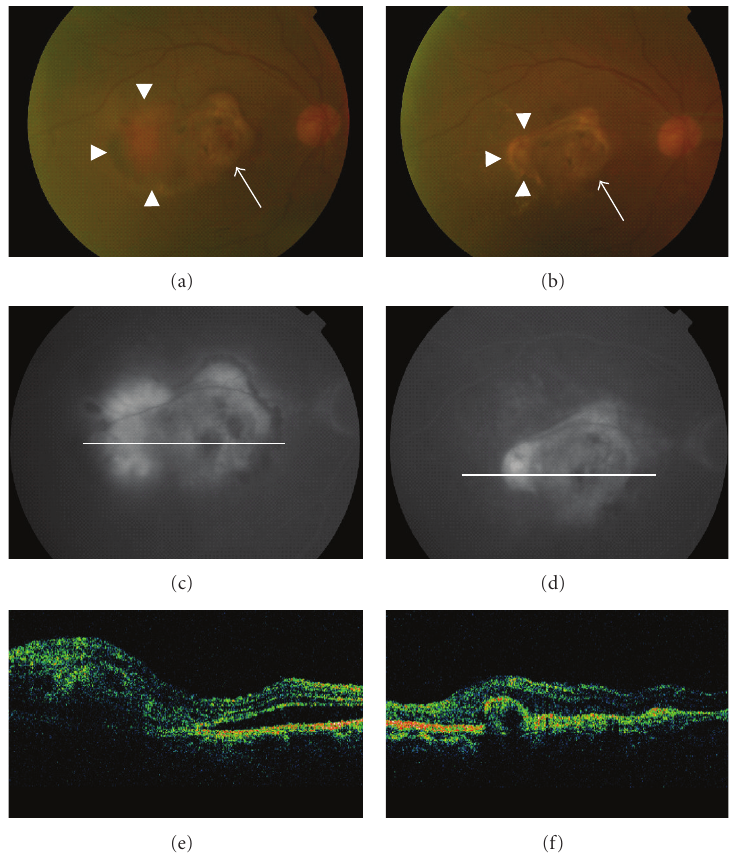
Figure 6: A 79-year-old male who received PDT for 27 months ago showed a recurrence of CNV (arrowheads), mainly at the temporal edge of the old scar (arrows) (a). Fluorescein angiography (FA) showed predominantly classic CNV (c), and optical coherence tomography (OCT) revealed a subretinal lesion before treatment (e). After the oral administration of alendronate for three months, the CNV became subretinal fibrosis (b) and no leakage was observed using FA (d). A remarkable decrease in the size of the subretinal lesion was observed using OCT